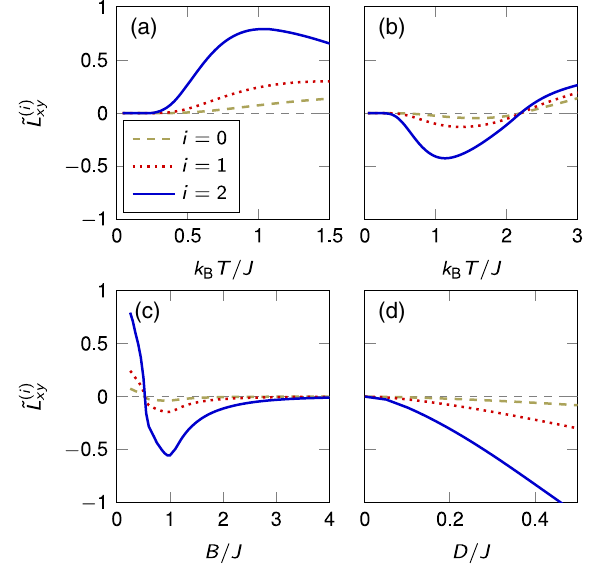
˜ L ð i Þ FIG. 15. Interaction-induced transverse conductivities xy [see Eq. (48)] for S ¼ 1 . (a) Low-field temperature dependence ˜ L ð i Þ 0 . 25 and D=J ¼ 0 . 3 . of xy ; the parameters read B=J ¼ ˜ L ð i Þ (b) High-field temperature dependence of xy ; the parameters ˜ L ð i Þ read B=J ¼ 1 . 2 and D=J ¼ 0 . 3 . (c) Field dependence of xy at T=J ¼ 1 , with D=J ¼ 0 . 3 . (d) DMI dependence of ˜ L ð i Þ xy on k B T=J ¼ 1 and B=J ¼ 1 . Notice the zero crossings DMI D at k B that are associated with topological phase transitions in the magnon spectrum: The zero crossing in (b) [(c)] is associated with the thermal phase transition (field-induced transition) studied in Sec. III B 5 (Sec. III B